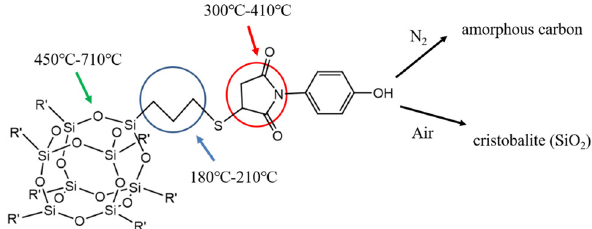
Figure 7: Pyrolysis process of POSS - 8Phenol in air or N 2 .